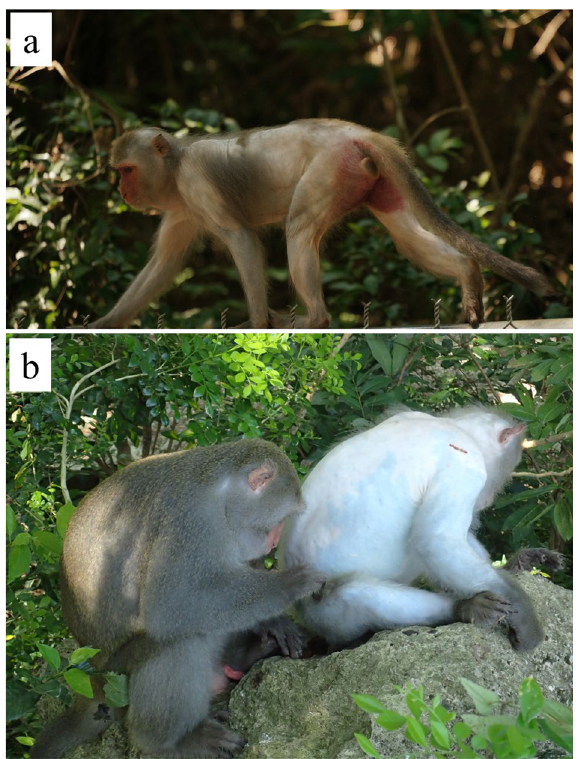
Figure 1. ( a ) An adult female Formosan macaque. ( b ) An adult male Formosan macaque on the right side with severe bilateral symmetrical alopecia compared with the Formosan macaque on the left side with normal